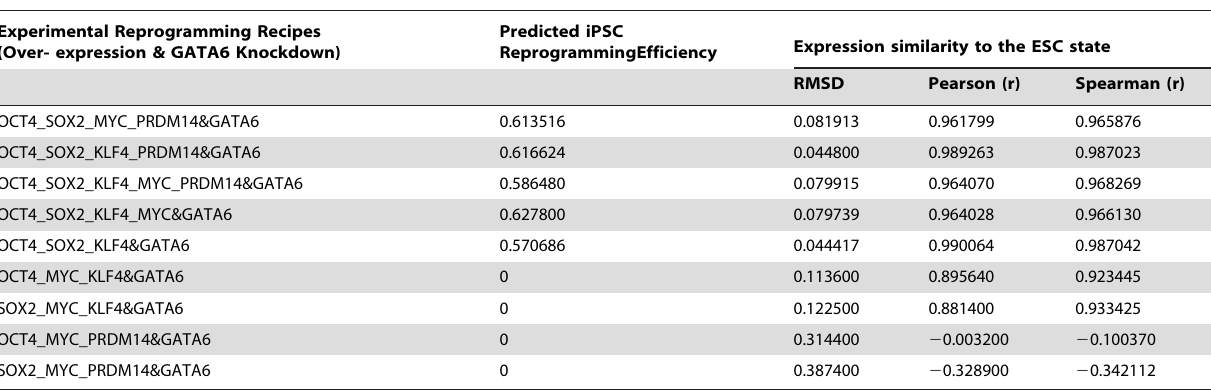
Table 4. Effect of GATA6 knockdown on